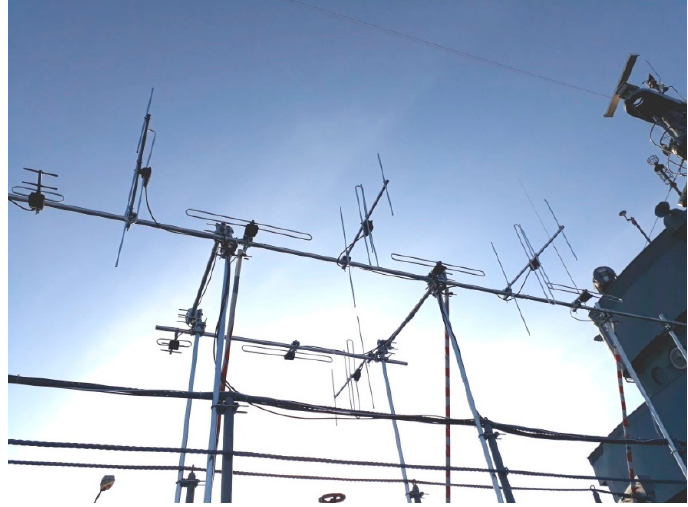
Figure 2. Receiving antenna array installed on the side of the ship.